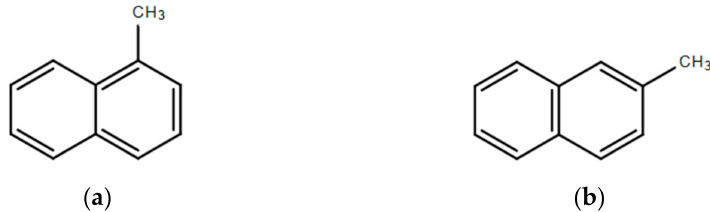
Figure 2. X-ray diffraction (XRD) analysis of raw ore.